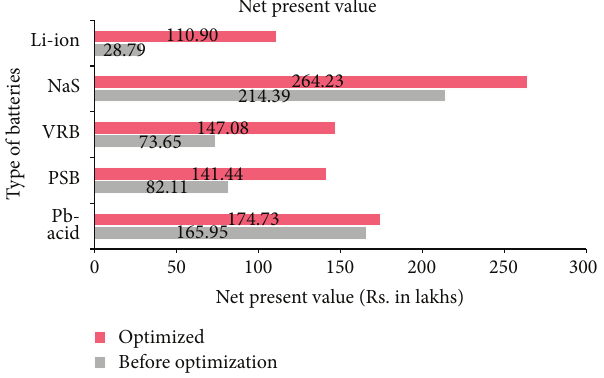
Figure 14: Benefit-cost ratios.